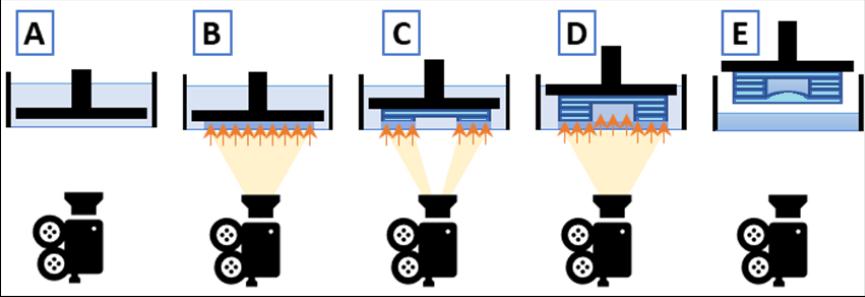
Figure 1. Different phases of printing a cantilever structure. ( A ) The printing platform moves to the end of the vat, where the base of the device will be created. ( B ) The DLP projector exposes all the base. ( C ) Only the channel walls are exposed by the DLP projector. ( D ) Once the channel is created, all the device has to be exposed in order to polymerize a cover for the channel. ( E ) It can be appreciated that the light exposed in ( D ) crossed through the channel and partially polymerized the channel cavity.